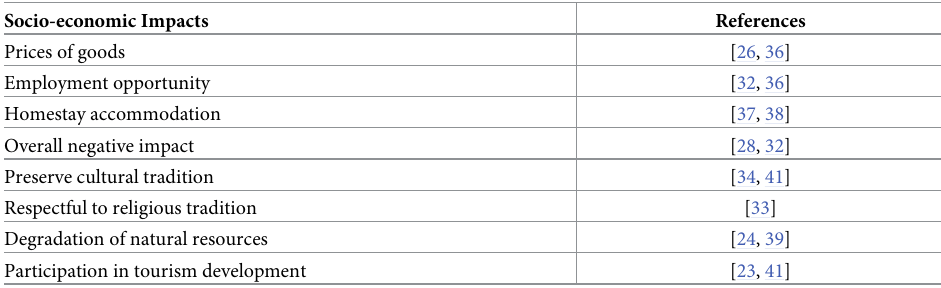
Table 1. Socio-economic impacts of ecotourism